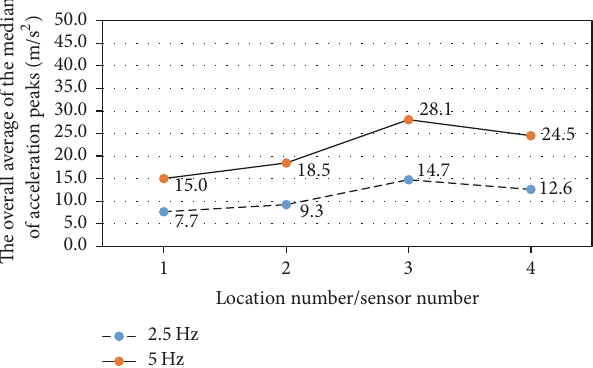
Figure 9: The overall average of the median of acceleration peaks for those three shaking tines in trail 1.